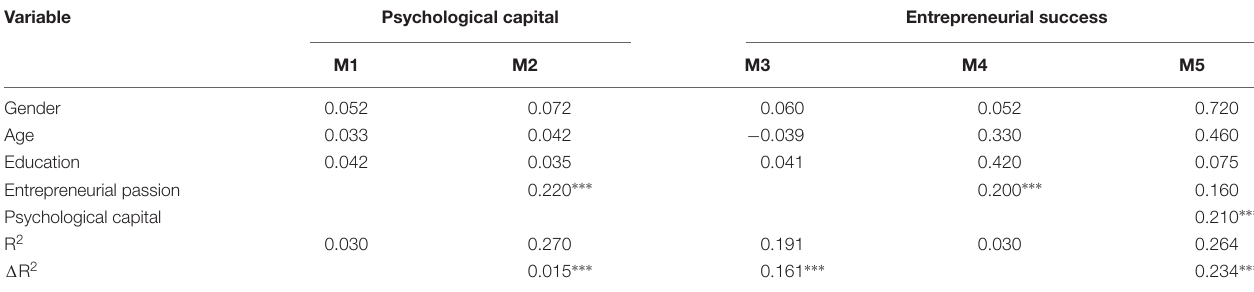
TABLE 3 | Analysis results of main effects and mediation effects.